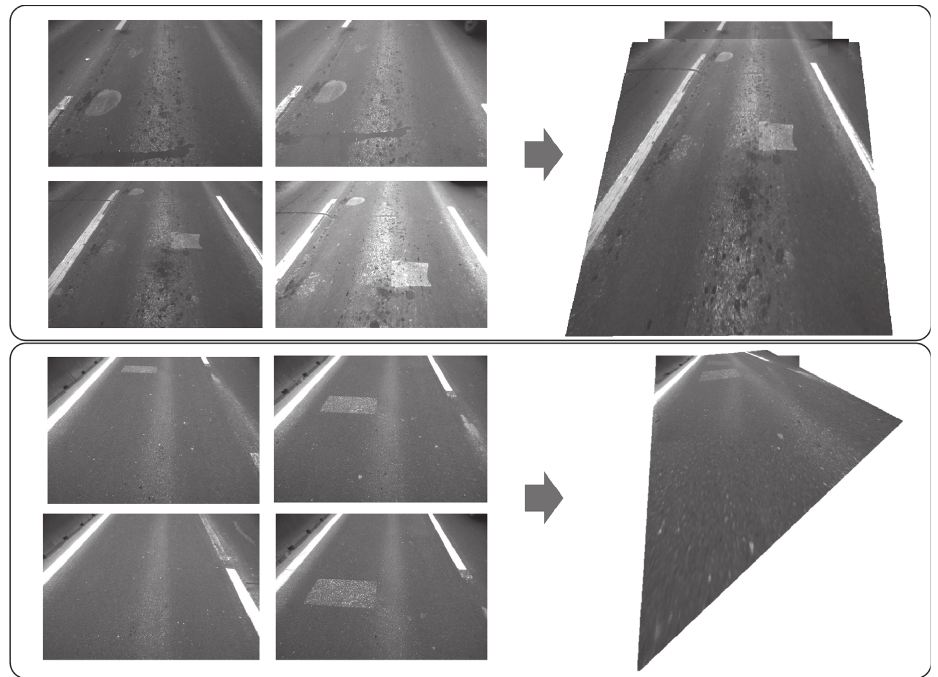
Figure 12: The stitching